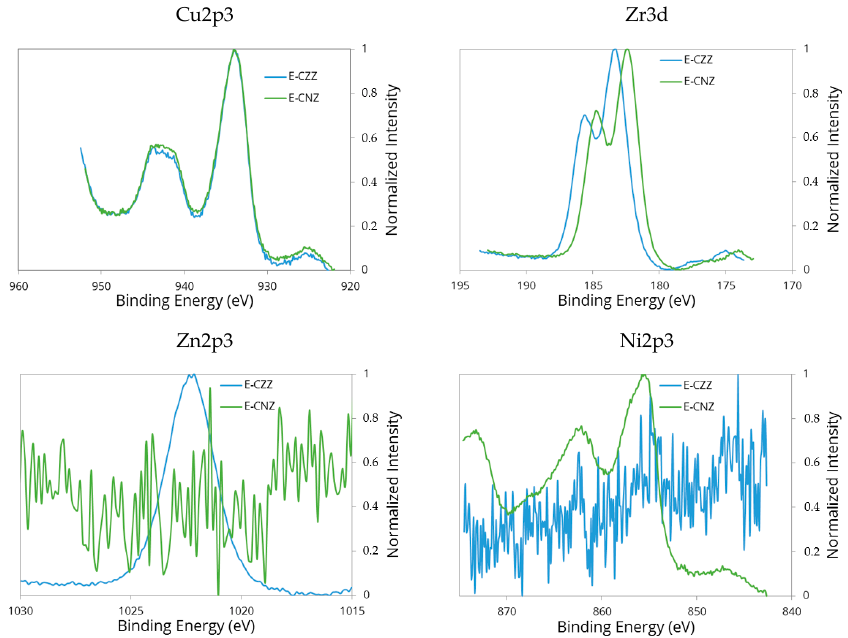
Figure 3. Cu2p 3 / 2 -, Zn2p 3 / 2 -, Ni2p 3 / 2 -, and Zr3d 5 / 2 lines in the XPS spectra for E-CZZ (blue) and E-CNZ Figure 3. Cu2p 3/2 -, Zn2p 3/2 -, Ni2p 3/2 -, and Zr3d 5/2 lines in the XPS spectra for E-CZZ (blue) and E-CNZ samples (green). samples